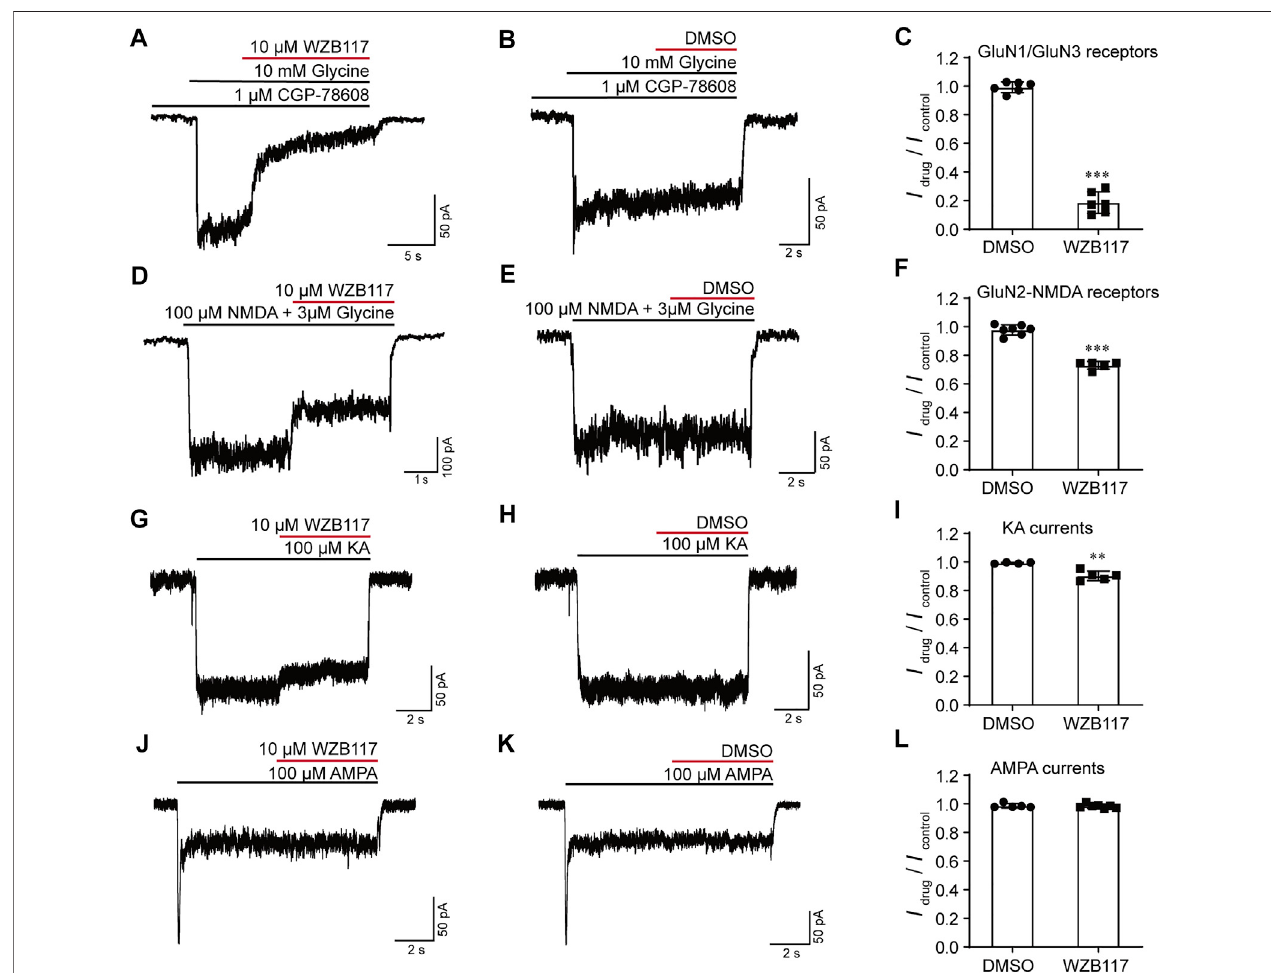
FIGURE 4 | Effects of WZB117 on the native iGluRs. (A – C) WZB117 (10 μ M) potently inhibited GluN1/GluN3 receptors on acutely isolated rat hippocampal neurons. (D – L) WZB117 (10 μ M) showed relatively weak inhibition of GluN2-NMDARs (D – F) and non-NMDA receptors (G – L) . Signi fi cance was tested using a t-test; p p < 0.05, pp p < 0.01 and ppp p <